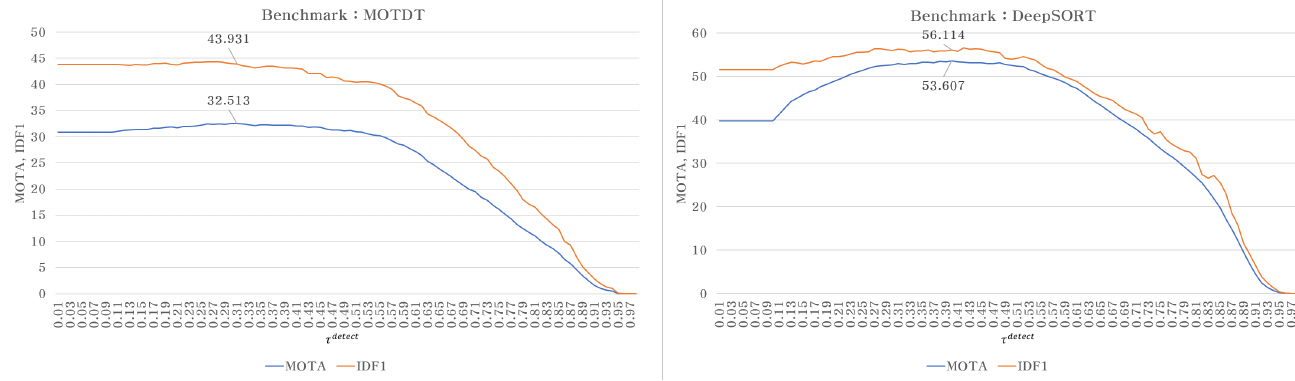
Figure 9. MOTA and IDF1 scores varying τ detect for two baseline trackers, MOTDT and